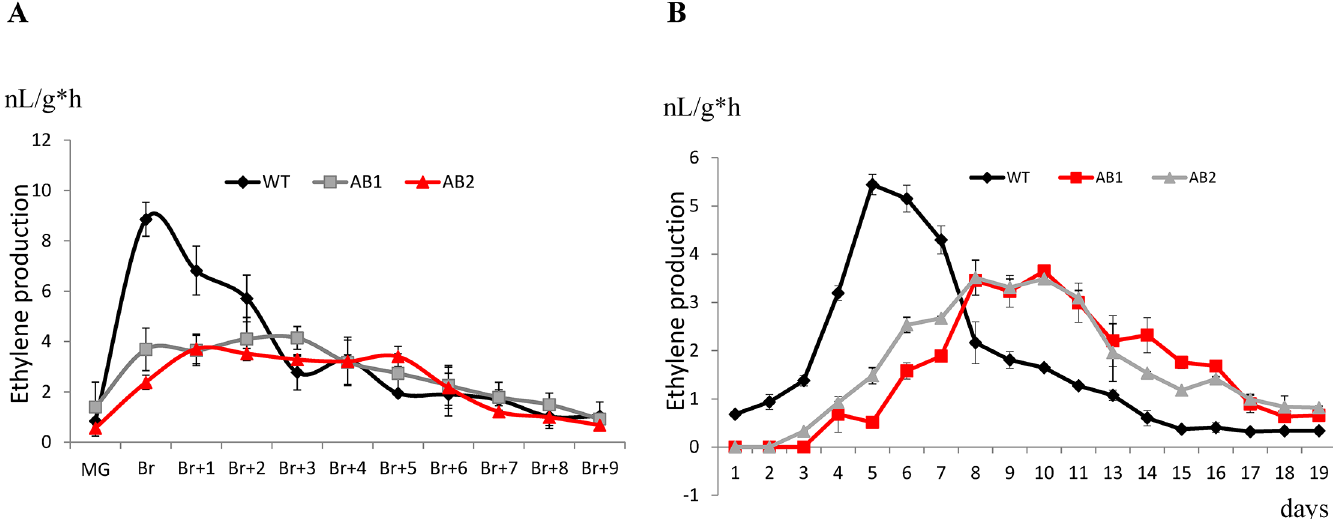
Fig 7. Ethylene production of SlARF2AB-RNAi fruits. (A) Ethylene production of wild-type and SlARF2AB-RNAi fruits picked at different ripening stages and assessed for ethylene production. MG = mature green stage; Br = breaker stage; Br+1 = 1 day post breaker stage; Br+2 = 2 days post breaker stage; Br +3, 3 days post breaker stage. (B) Ethylene production of wild-type and SlARF2AB-RNAi fruits picked at MG stage and left on the bench. Ethylene was measured at different days post mature green stage. Values represent means of at least 10 individual fruits. Vertical bars represent SD. AB1 = SlARF2AB-RNAi line 311; AB2 = SlARF2AB-RNAi line 223.